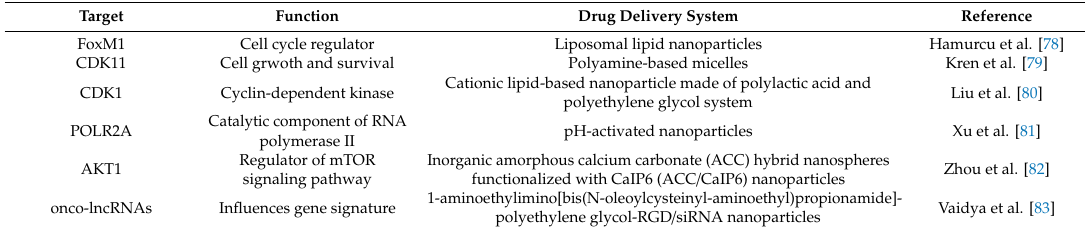
Table 3. Small-interfering RNA (siRNA) drug delivered systems with the potential to be applied to triple-negative breast cancer. lncRNAs: long noncoding